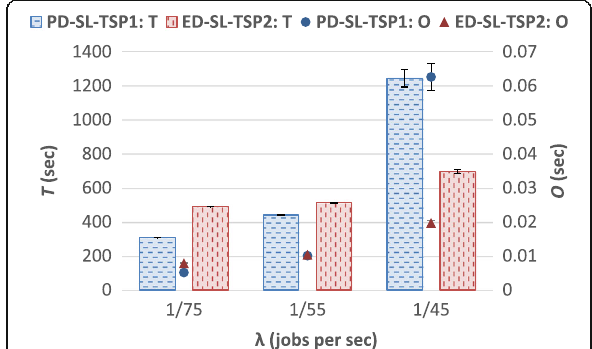
Fig. 15 Effect of λ cs on T and O when using the CyberShake workload with m = 20